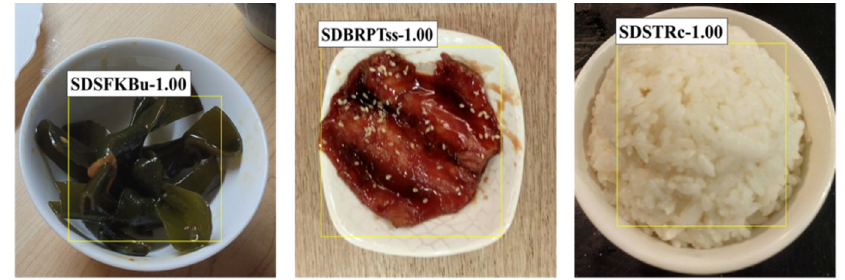
Figure 9. Recognition results for different types of single dishes.